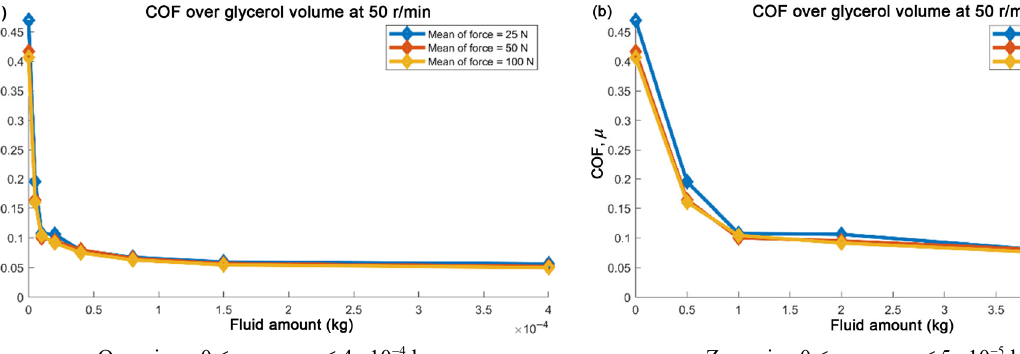
Fig. 15 COFs for varying fluid volumes and normal